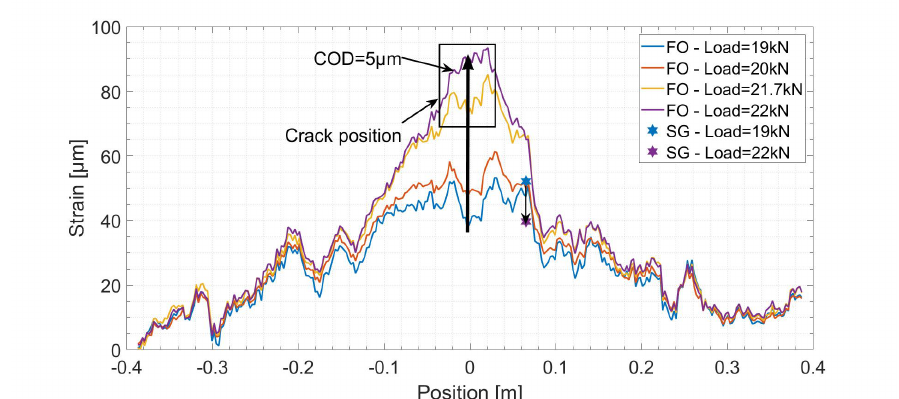
Figure 10. Spatial strain distribution over the length of Fiber Optics (FO) Line 1 before and after the creation of the first micro